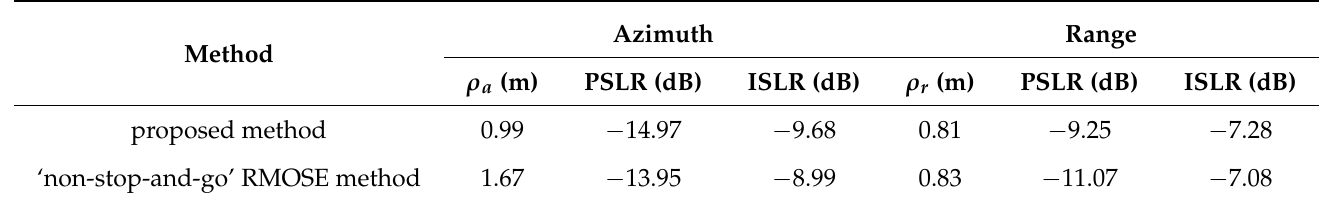
Figure 14. Comparison of azimuth and range profiles for the selected isolated strong target. ( a ) Az- imuth profile of the proposed method. ( b ) Range profile of the proposed method. ( c ) Azimuth profile of the ‘non-stop-and-go’ RMOSE method. ( d ) Range profile of the ‘non-stop-and-go’ RMOSE method. Table 5. Comparison of focusing results between proposed and ‘non-stop-and-go’ RMOSE